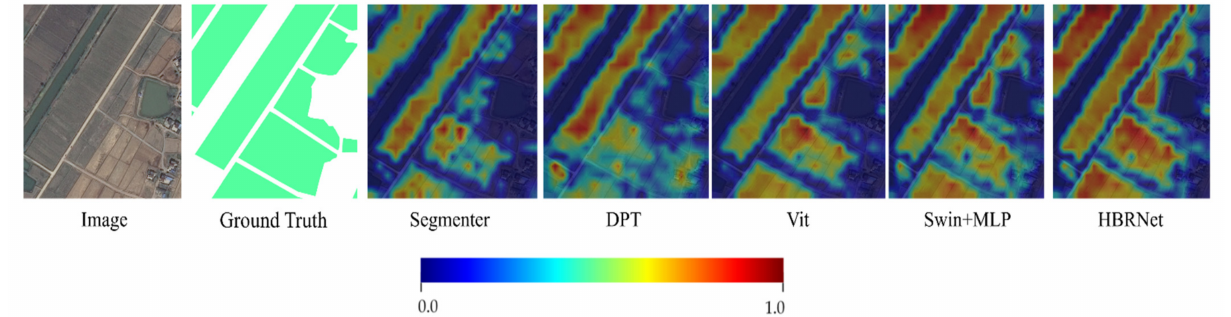
Figure 14. The probability heat map of cropland. The redder the red represents the greater likelihood that the section is arable land and indicates that the experimental results are closer to the true